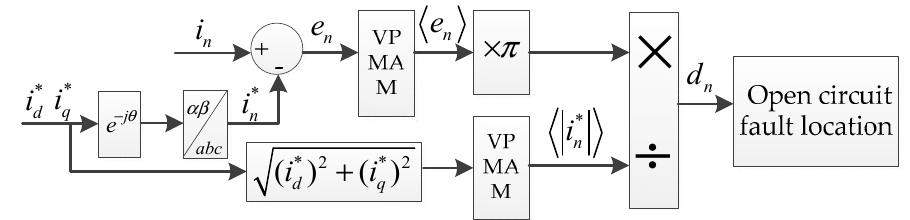
Figure 5. Diagram of the proposed open circuit fault diagnostic algorithm.